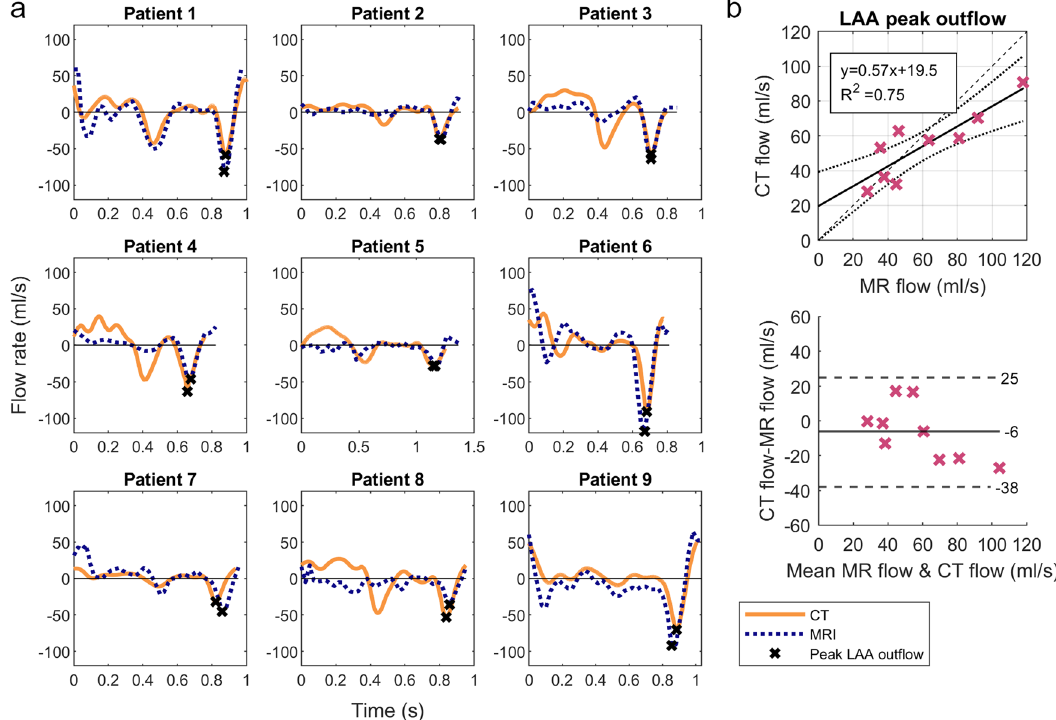
Fig. 5 LAA Flow Rate. a Flow rate though LAA ori fi ce calculated based on 4D fl ow MRI and time resolved CT, peak LAA out fl ow is marked with X. b Comparison of Peak LAA Out fl ow Rate in 4D fl ow MRI and 4D CT. Top: Linear Regression: Solid line indicates Linear Regression line; Dotted lines indicate 95% con fi dence bounds; Dashed line indicates identity line. The box shows the linear regression equation and the coef fi cient of determination R 2 . Bottom Bland-Altman Plot, Solid line indicates the bias, Dashed lines indicate ±1.96 standard